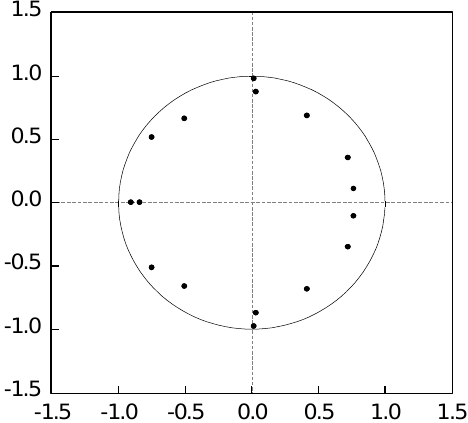
Figure 5. Unit root distribution map.